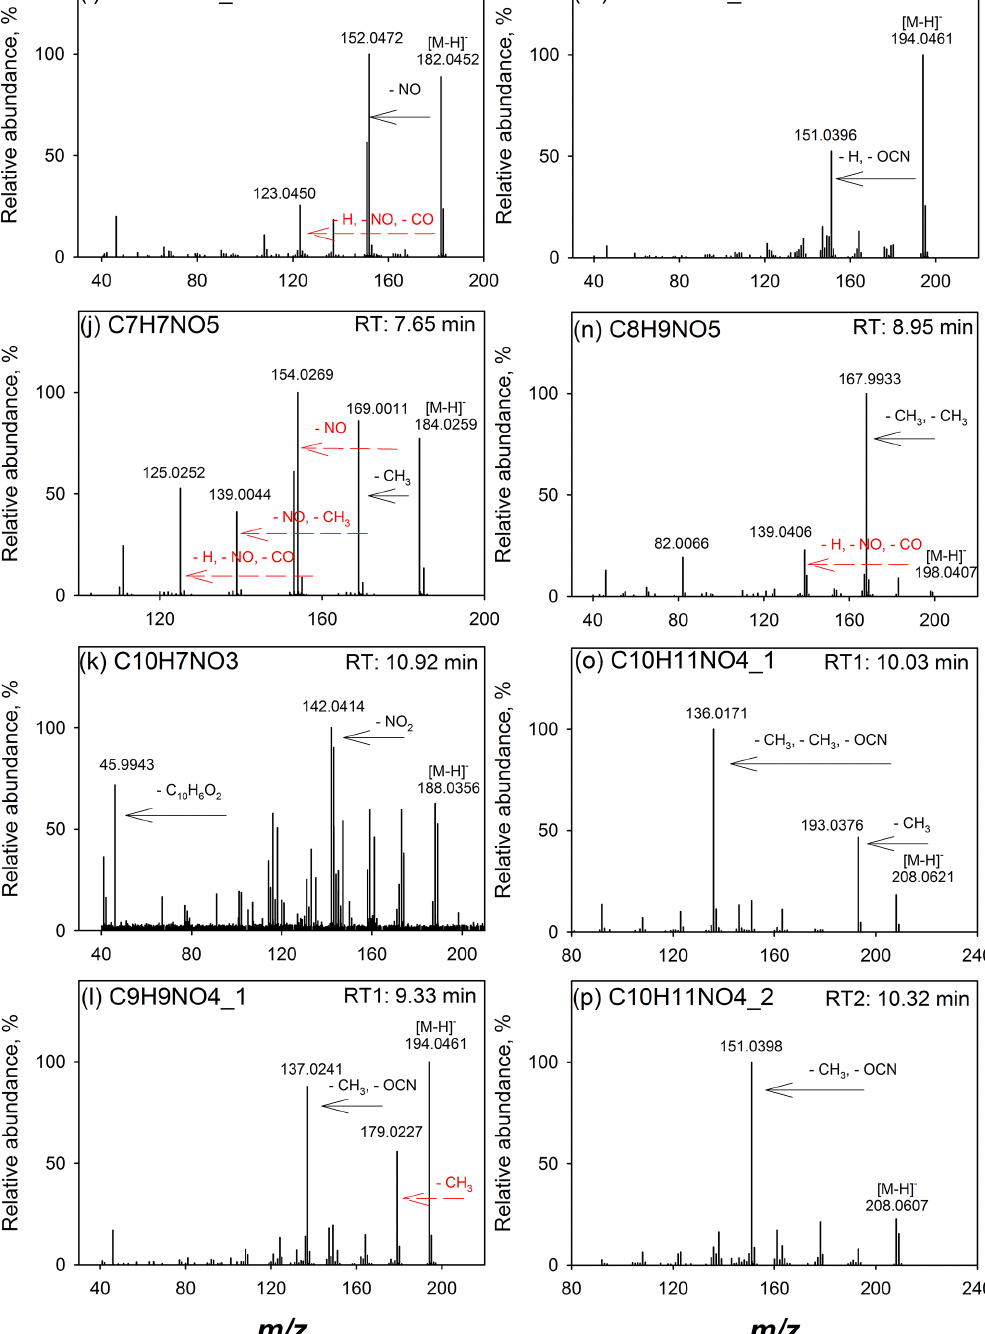
trol (QA / QC) procedures applied for NAC quantification were provided in Xie et al. (2017a). Field blank and back- ground samples were free of contamination for NACs. Av- erage recoveries of standard compounds ranged from 75.1 %